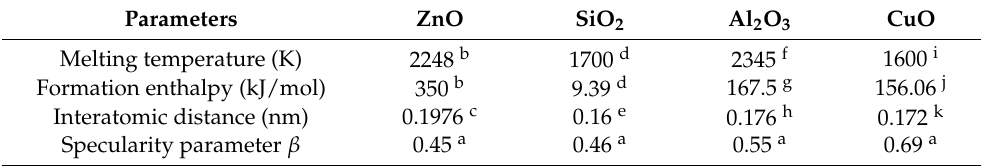
Table 2. Material properties of oxide nanoparticles (at T = 300 K) used in Equation (4).